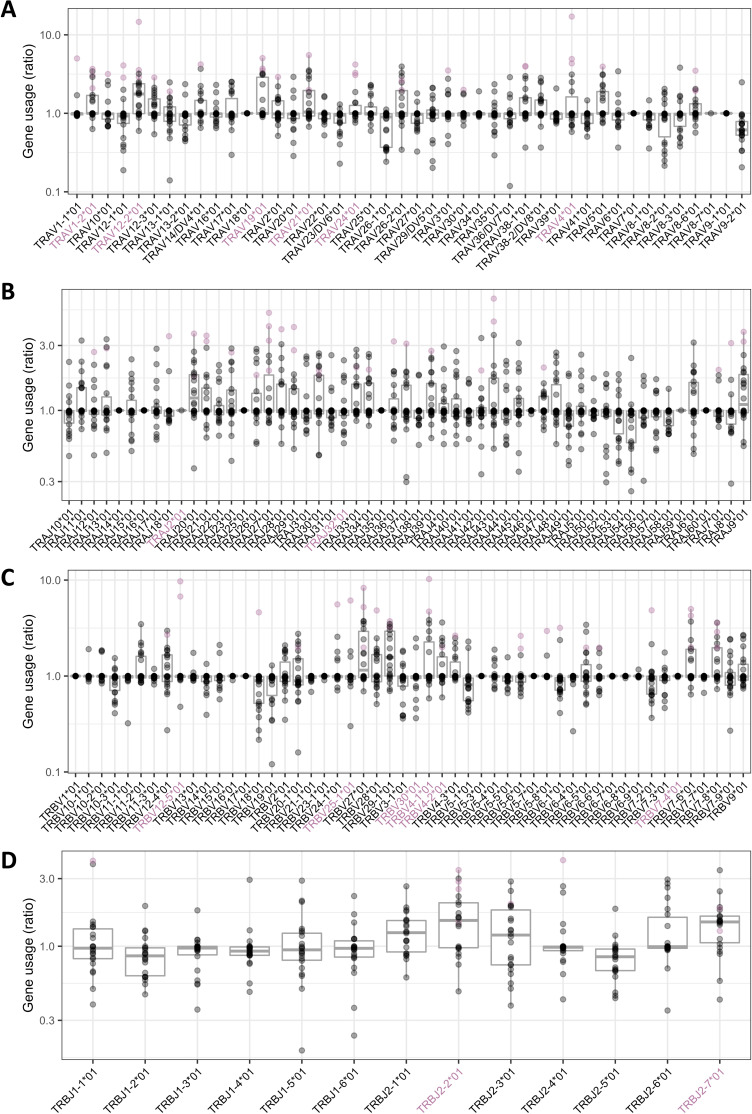
The expanded T cell receptors (TCRs) show characteristics of antigen-driven responses in their V and J gene usage.Relative frequency of V and J alpha and beta gene usage in the set of PT1 expanded TCRs (≥8) from 22 individuals, compared to the frequency in their respective pre-sensitization repertoires. Each dot is a patient. Genes significantly over-represented in the expanded set (see text for statistical test) are colored pink. Under-represented genes are not included in this figure, since the small number of expanded TCRs in some patients resulted in a large but less meaningful set of under-represented genes due to sampling. Genes colored pink on the x-axis are those that were significantly over-represented in the combined expanded set (1858 unique alpha TCRs and 2019 unique beta TCRs).